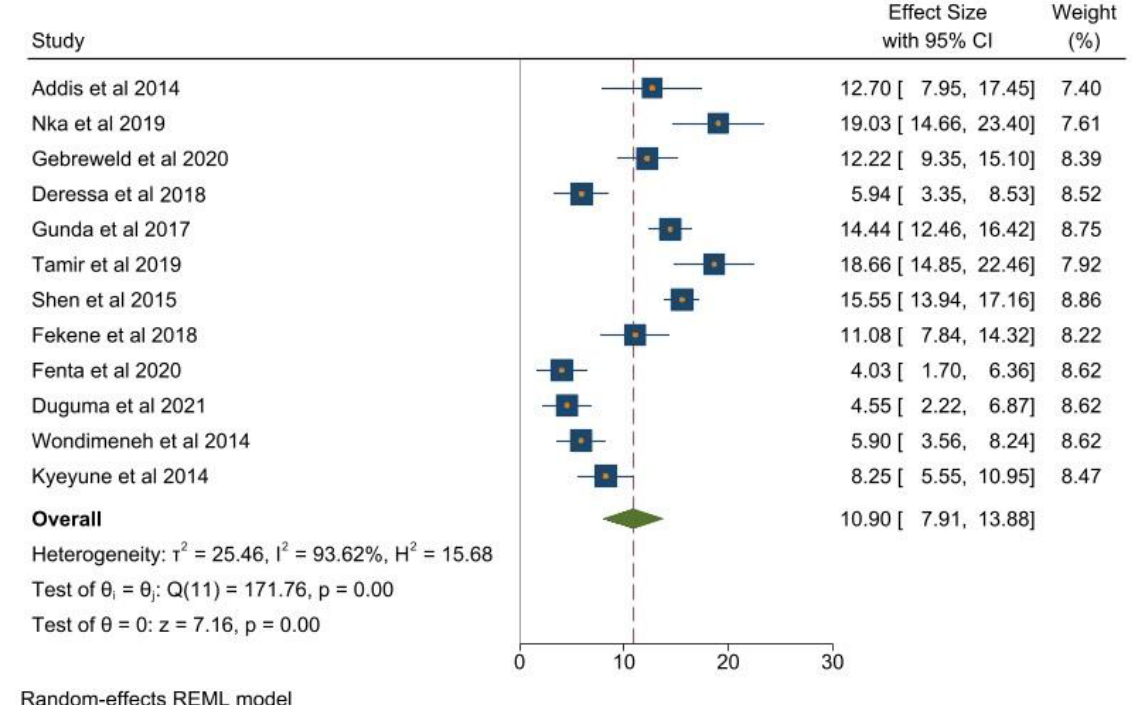
Figure 3. Pooled prevalence of thrombocytopenia among 6686 HIV patients from 12 studies [1,18 – 28].